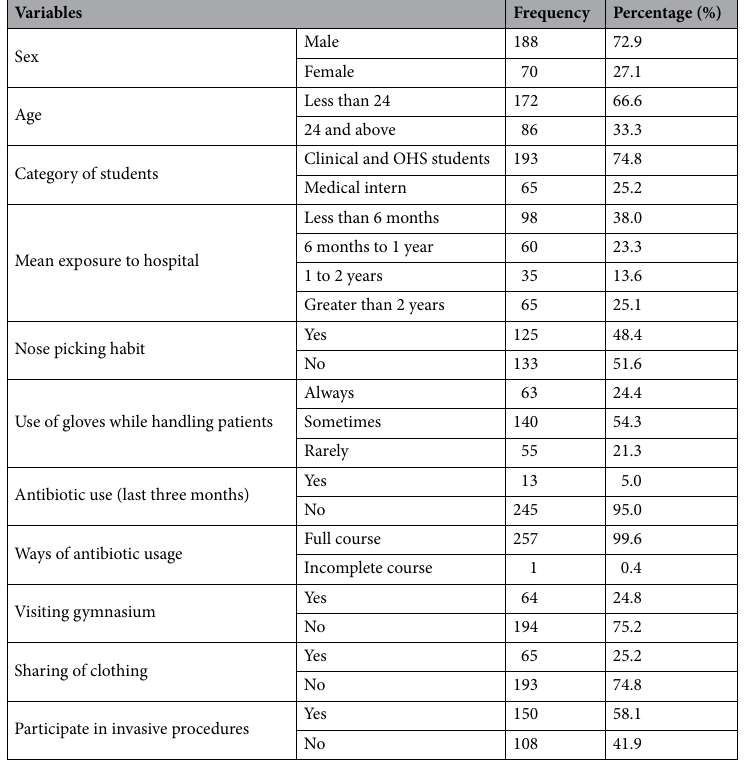
Table 1. Socio-demographic, clinical and behavioral characteristics of medicine and health science students of Arba Minch University, Arba Minch, southern Ethiopia, 2020.